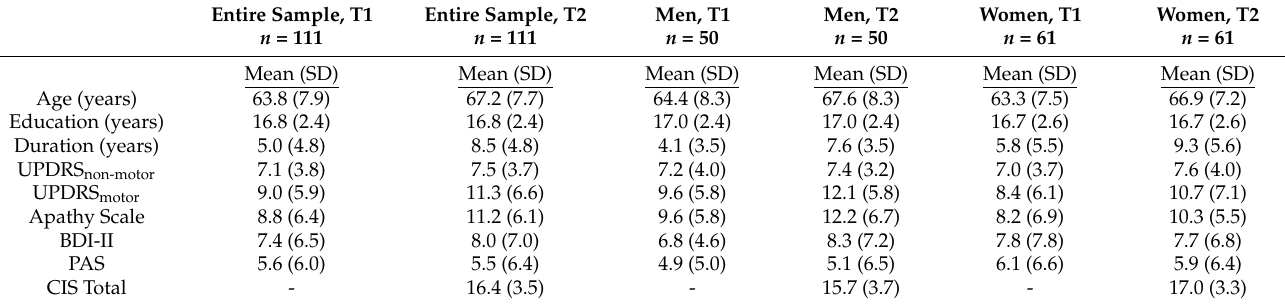
Table 1. Demographic and Clinical Characteristics and Performance on Measures for Participants in Current Sample ( n = 111) at T1 (2017–2018) and T2 (2021): Entire sample, men, and women. Entire Sample, T1 n =